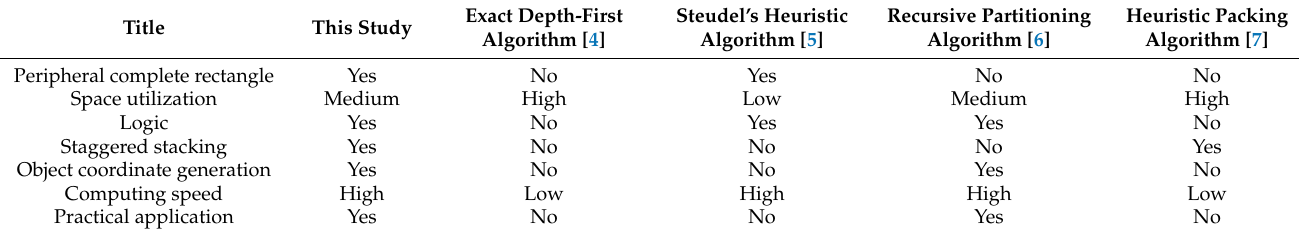
Table 1. Algorithm